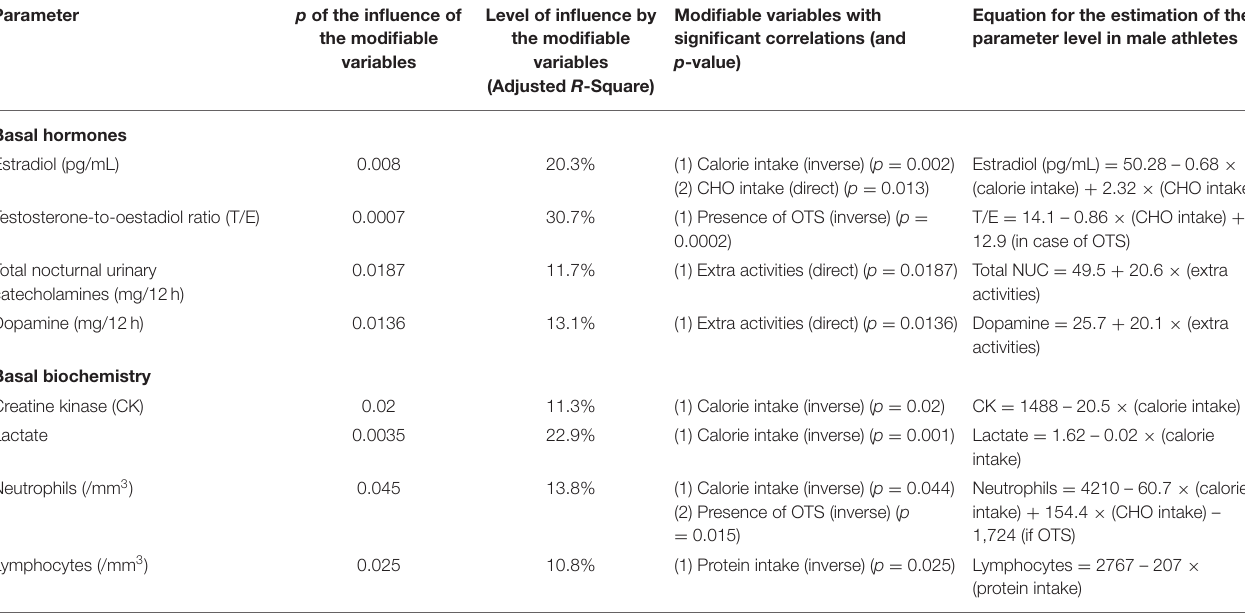
TABLE 3 | Modifiable patterns as independent predictors of basal hormones and biochemical parameters (multivariate linear regression analysis).